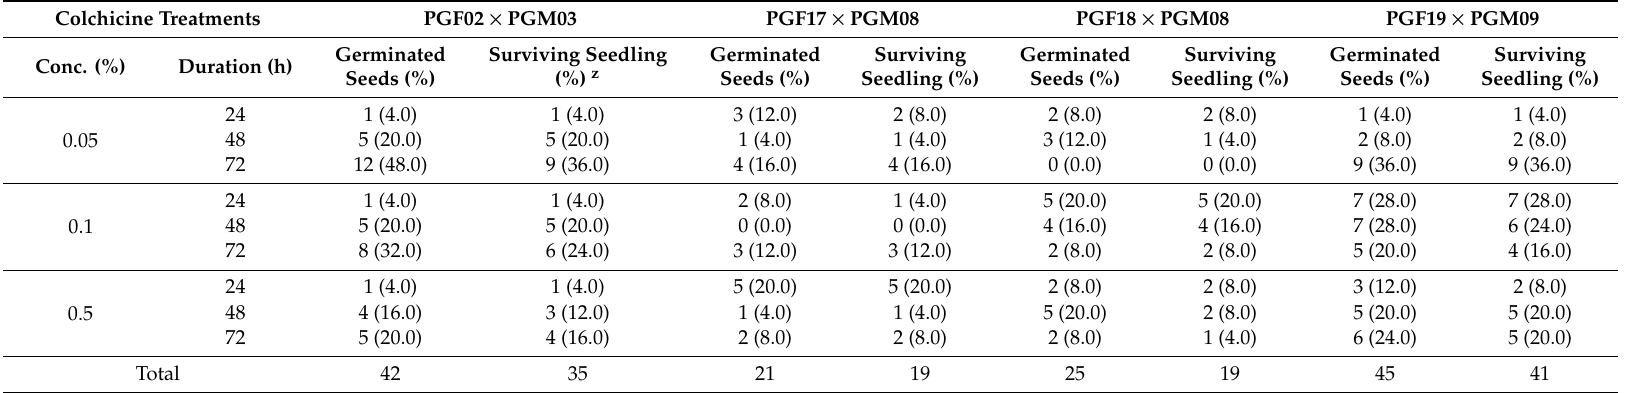
Table 1. E ff ects of colchicine treatments on the germination rate and surviving seedling rate of pointed gourd.